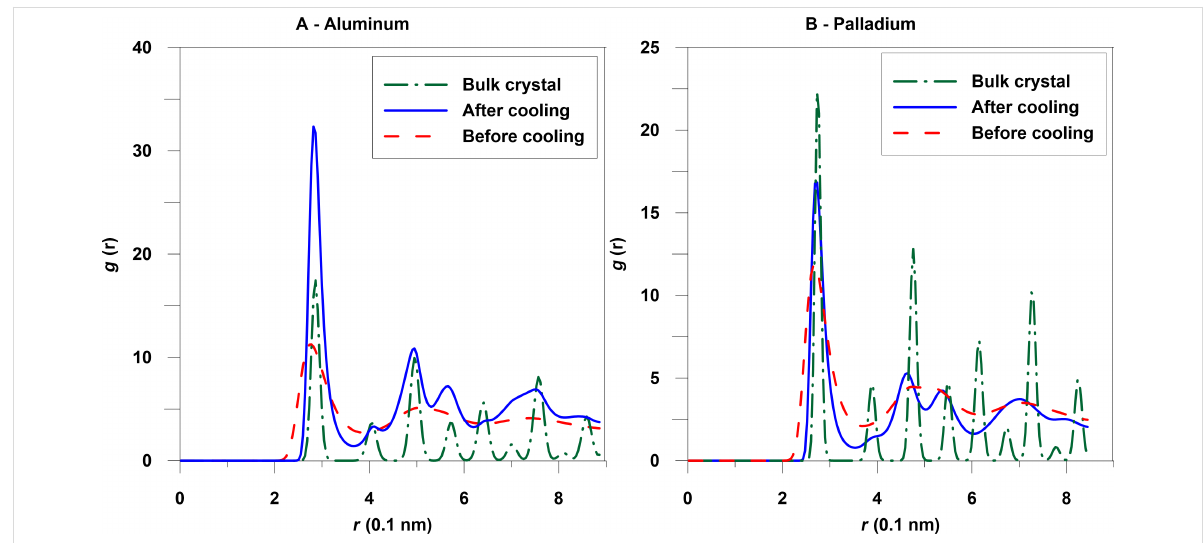
Figure 9: Radial distribution function for the Al and Pd nanoparticles containing 20000 atoms for the bulk crystal at a temperature of 300 K and after cooling, and at 1150 K for palladium before cooling, and at 750 K for aluminum before cooling.